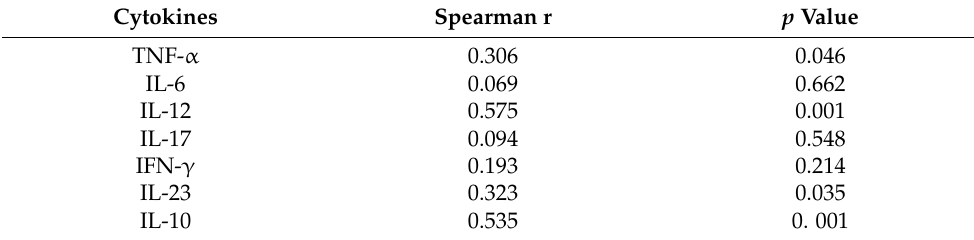
Table 5. Correlation between Gal-3 and pro- and anti-inflammatory cytokines.